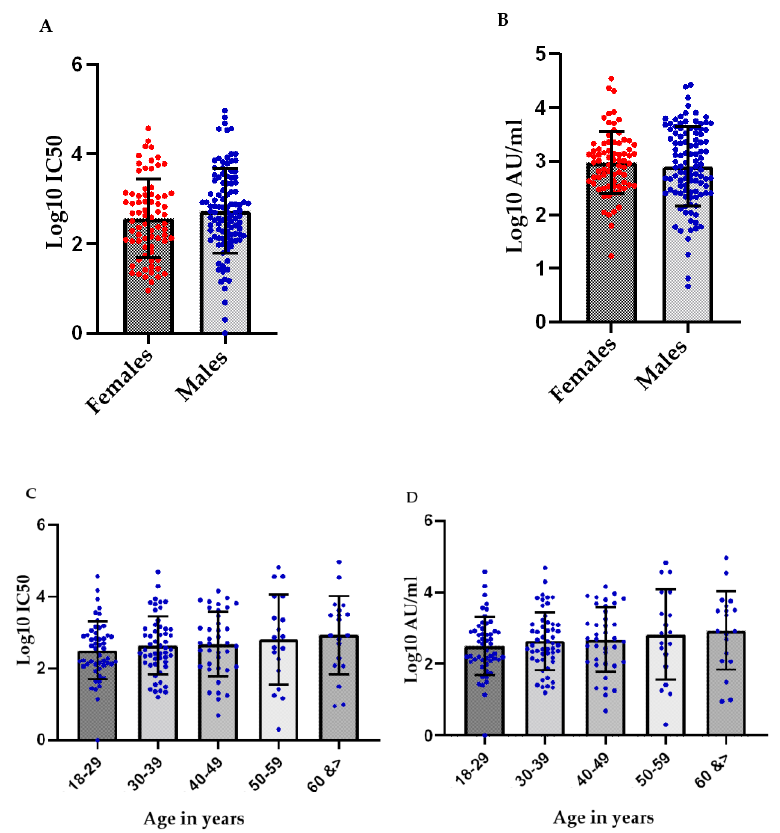
Figure 5. Distribution of log10 IC50 and log10 AU/ml values obtained following pseudotyped lentivirus antibody neutralization assay, and SARS-CoV-2 IgG II Quant immunoassay by sex ( A , B ) and age ( C , D ). Table 1. Age and sex distributions of study